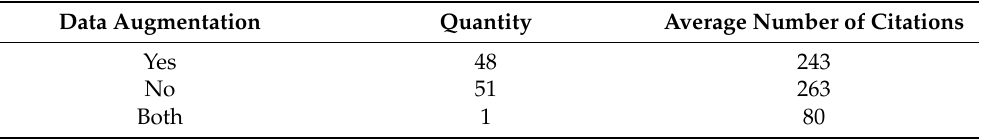
Table 10. Data augmentation.